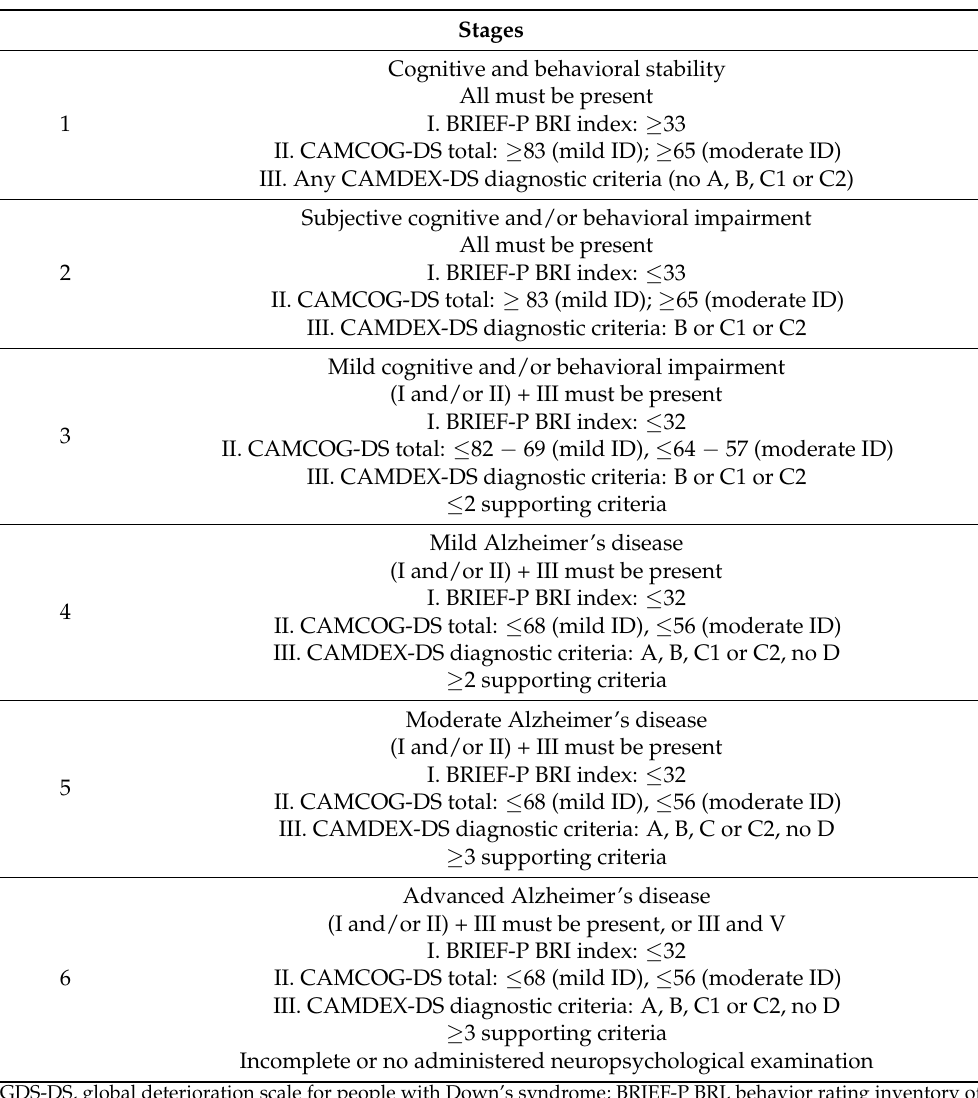
Table 2. Stages and diagnostic criteria for each stage of the